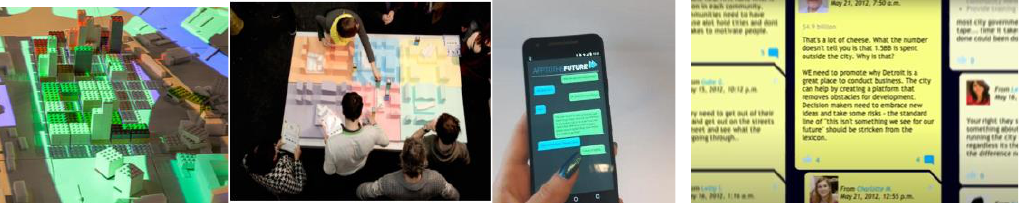
Figure 2. Various serious urban